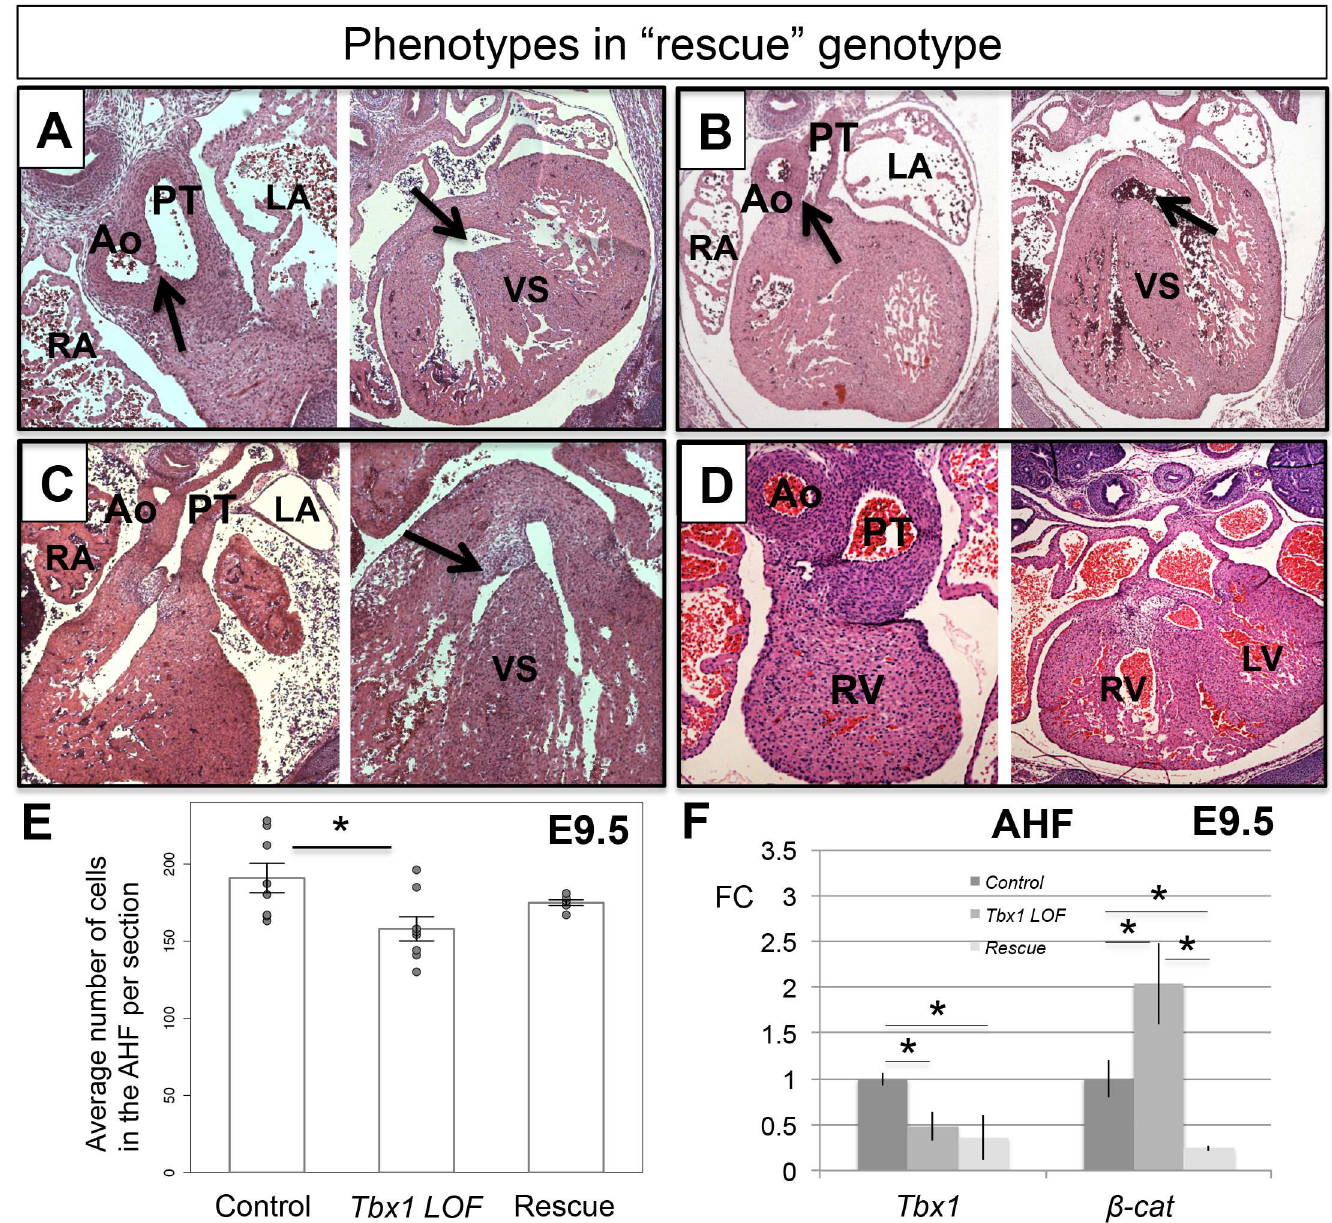
Fig 5. Histology analysis of representative embryos with the “rescue” genotype. Transverse H&E histological sectionsof hearts from E14.5 significantly rescued embryos ( Tbx1 LOF with loss of one alleleof β -catenin in the Mef2c-AHF-Cre domain). (A) An embryonicheart with a thin septum formed that separates the Ao and the PT (top black arrow), and a small VSD comparedto the usual PTA-VSD in Tbx1 LOF embryos (Fig 2C). (B) Example showinga DORV (middleblack arrow), with a separateAo and PT; normal ventricular septationis present. (C) Exampleof a heart showinga partially rescuedseptationbetweenthe Ao and PT (middle black arrow) and normalseptation betweenthe two ventricles(right black arrow). (D) Rescued septation betweenthe Ao and PT. (E) Mef2c-AHF-Cre lineagequantification from the same area shown in Fig 2G for control, Tbx1 LOF and rescuedembryos. (F) Detection of Tbx1 and β -catenin by qRT-PCR in control, Tbx1 LOF and rescuedembryos. Statistical significanceof the difference in gene expressionwas estimated using two-tailedt-test, FC = fold change,p values < 0.05. Error bars = standard deviation(SD). Abbreviations: RA = right atrium, RV = right ventricle, LA = left atrium, LV = left ventricle, Ao = Aorta, PT = pulmonary trunk, VS = ventricular septum, PTA = persistent truncus arteriosus, VSD = ventricular septal defect, DORV = doubleoutlet right ventricle, OFT = outflow tract.